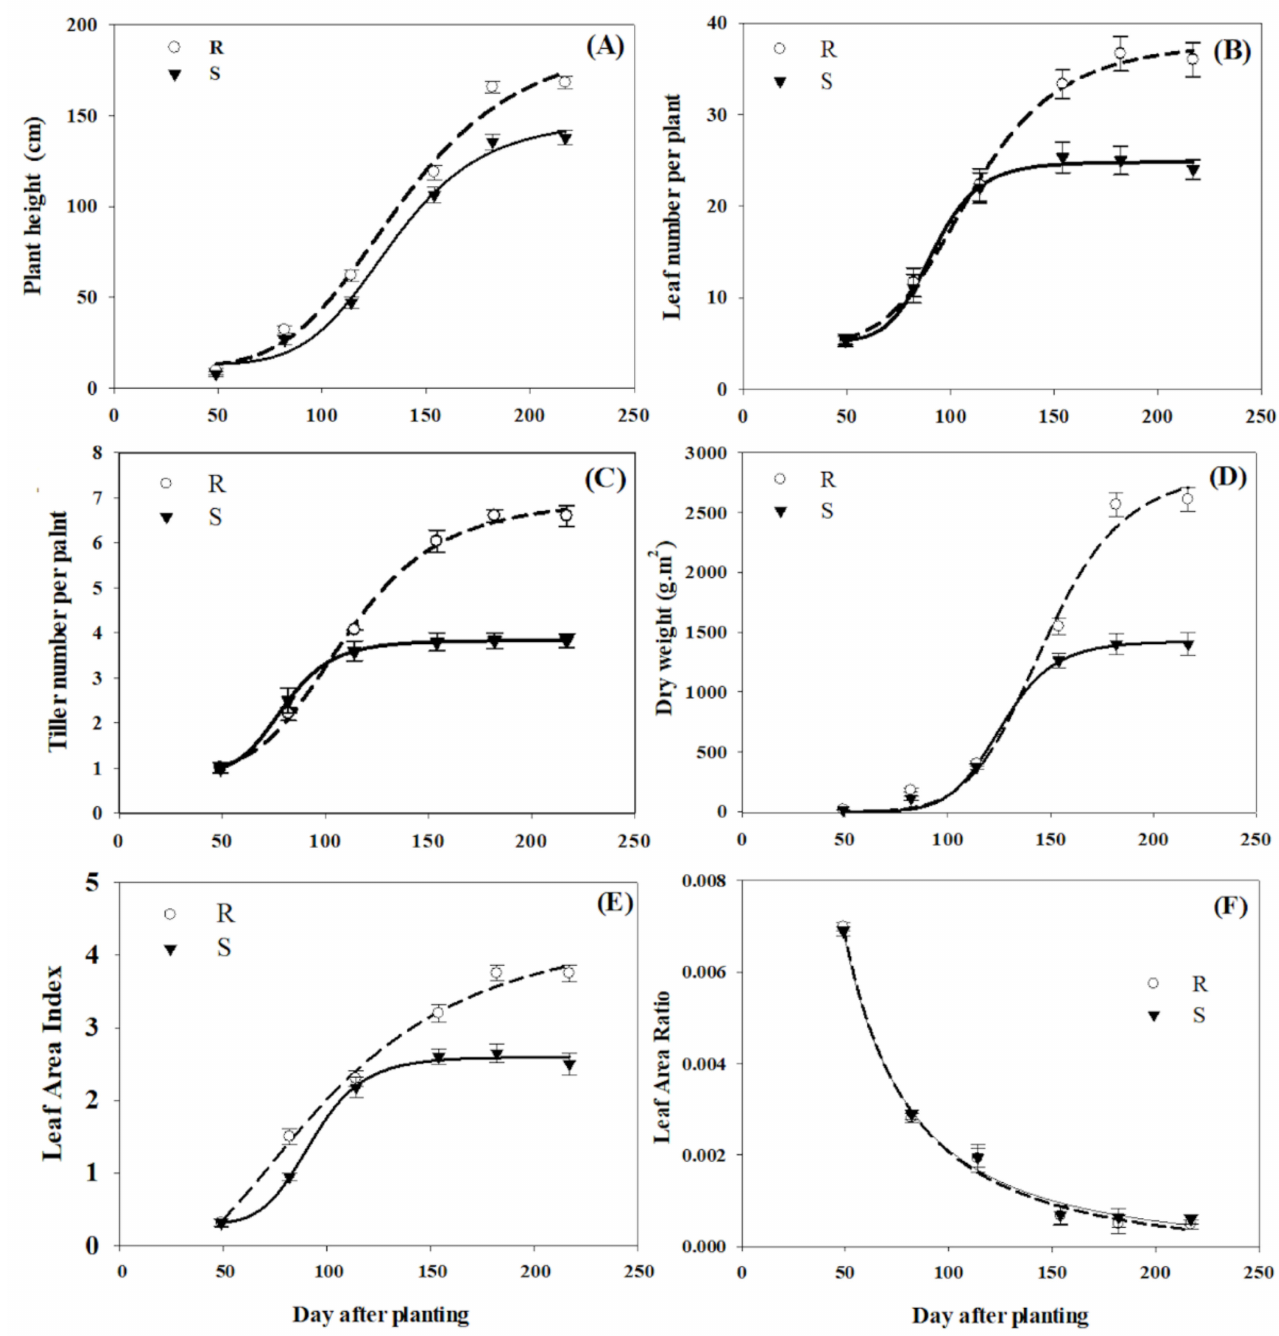
Figure 1. Comparison of the growth characteristics of resistant (R) and susceptible (S) P. brachystachys sub-populations to the ACCase-inhibiting herbicides. ( A ) Plant height, ( B ) leaf number per plant, ( C ) tiller number per plant, ( D ) dry weight, ( E ) leaf area index, and ( F ) leaf area